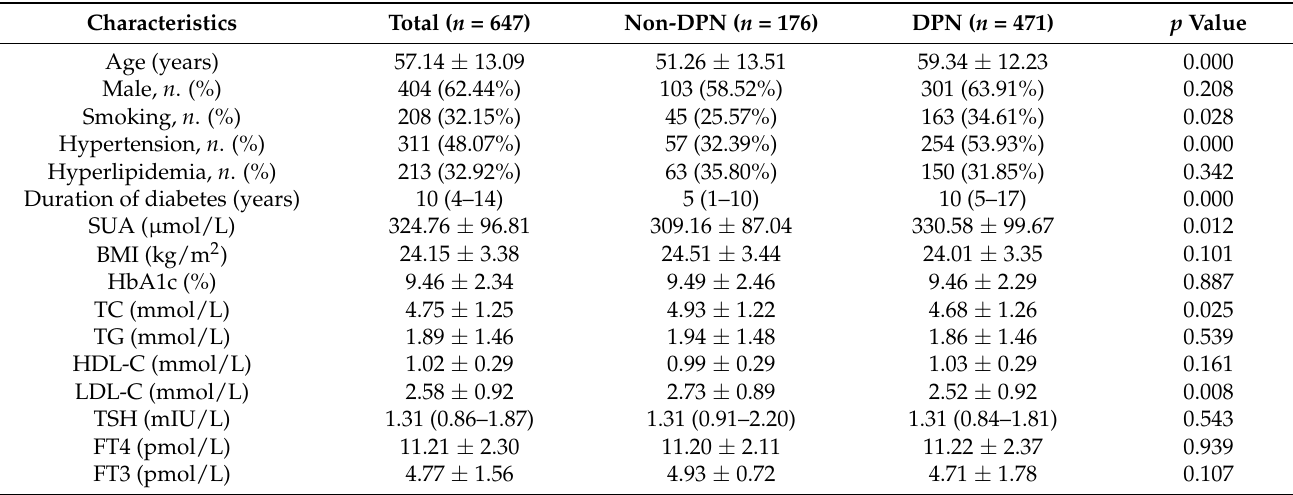
Table 1. Characteristics of the 647